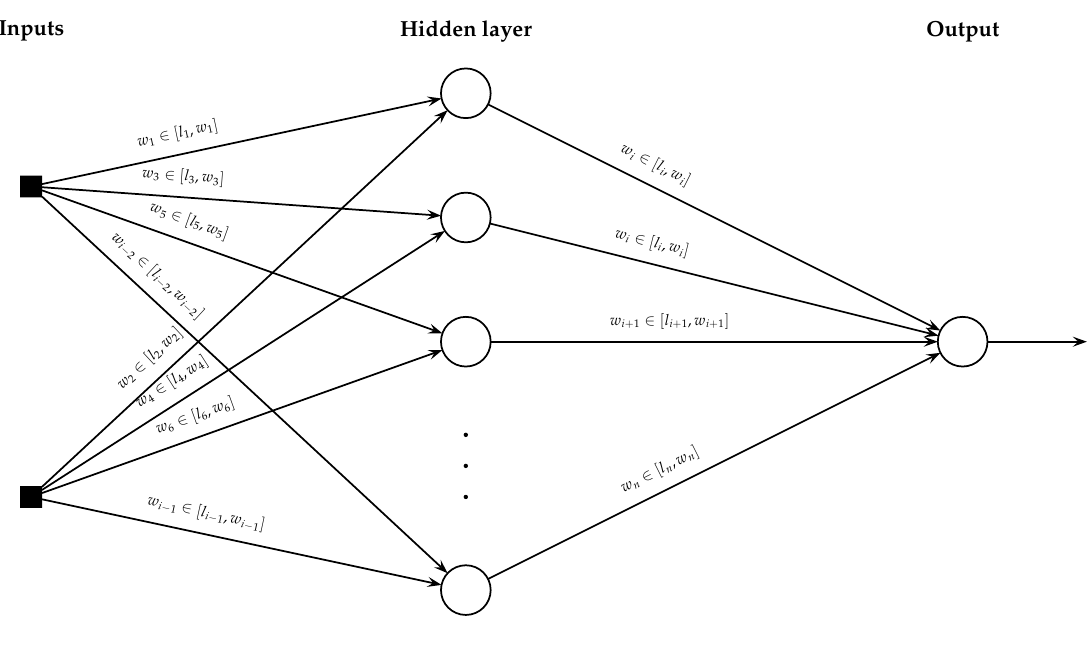
Figure 1. Typical example of a weight-constrained neural network with a single hidden layer